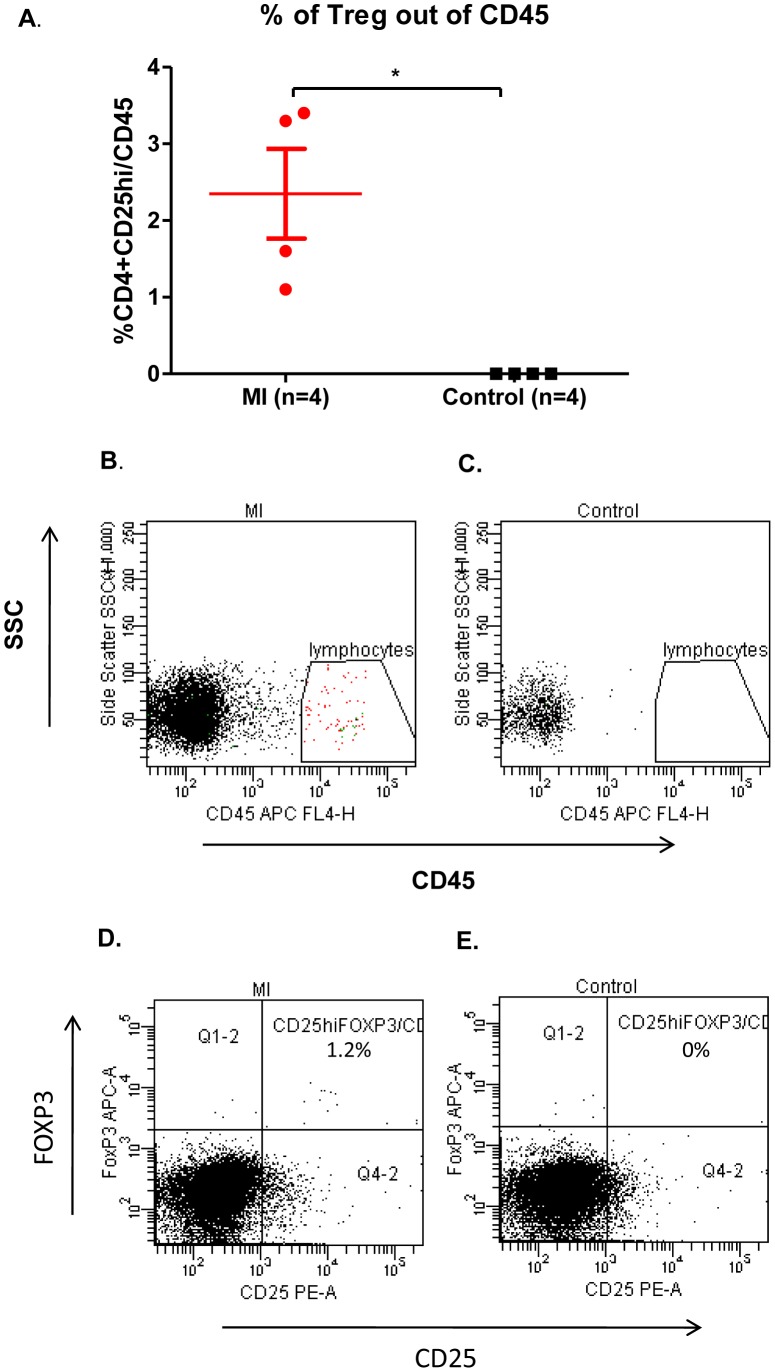
Tregs migrate to the injured heart.(A) FACS analysis records the numbers of Tregs (CD4+CD25hi cells) expressed as a percentage of the total number of CD45 cells after myocardial infarction. (B–C) Representative FACS recordings of the kinetics of CD45 presence in mice with experimentally induced myocardial infarction compared with control mice. (D–E) Representative FACS pictures of CD25+FOXP3 out of CD4 in infarct heart or control heart. *p<0.03 based on Mann-Whitney test, n =  4;